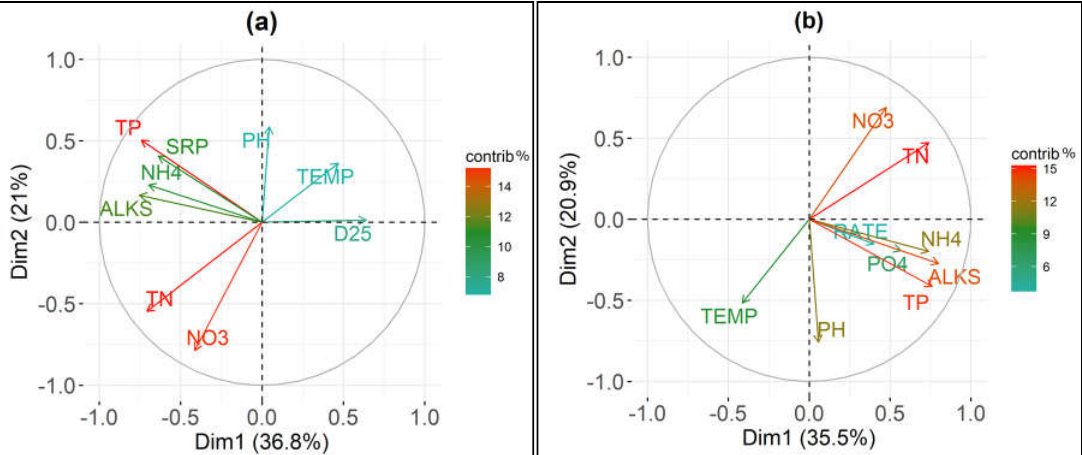
Figure 4. Box plot of the OxRate, amount of ammonium oxidised in each day (μg NH 4+ /L day) to reduce the ammonium concentration from 25% to 95% of the initial concentration in amended microcosms. Note that for samples of Lakes Candia and Piano the experiment was performed only once during the study. See Figure 3 for box plot statistics.